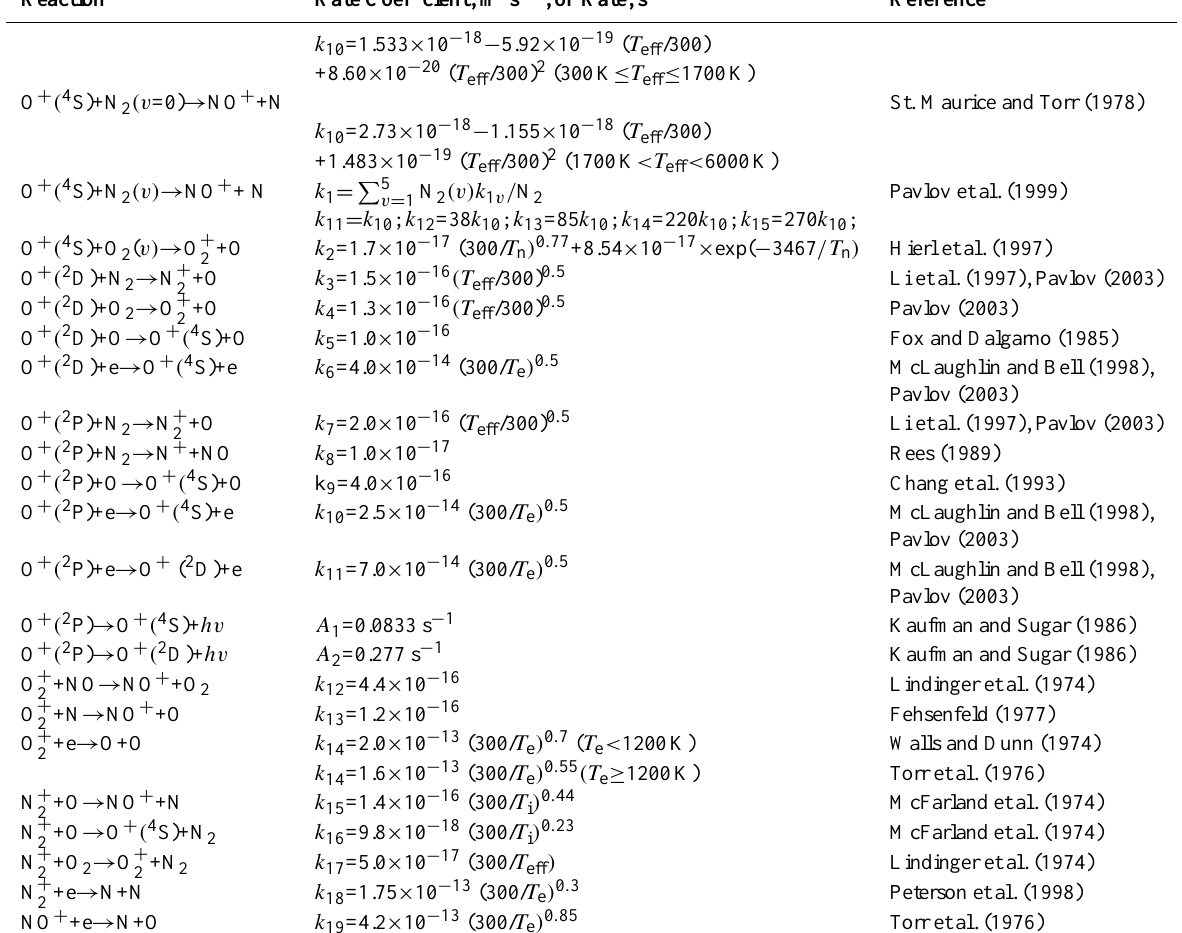
Table 1. Chemical reactions and rates included in the ionospheric model. T eff =( m i T n + m n T i ) /( m i + m n ) +0.329 E 2 , where E is the electric field perpendicular to the geomagnetic field in mV/m.